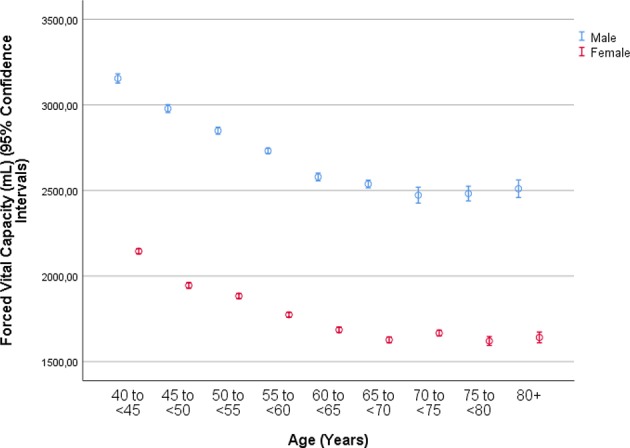
Graph showing the distribution of the forced vital capacity, stratified by age and gender, in the Ural Eye and Medical Study.